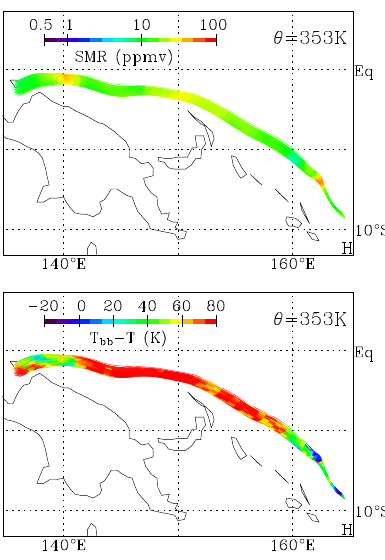
Fig. 11. (Top) the same as the bottom panel (353K) of Fig. 10, but for three-day portion of the backward trajectories, and (bottom) the same but colour-coded by the difference between the equivalent blackbody temperature T bb observed by geostationary satellite and the air temperature T ( δT bb ≡ T bb − T ). Dark colours indicate penetrating convective clouds while warm colours cloud-free air at or above trajectory.